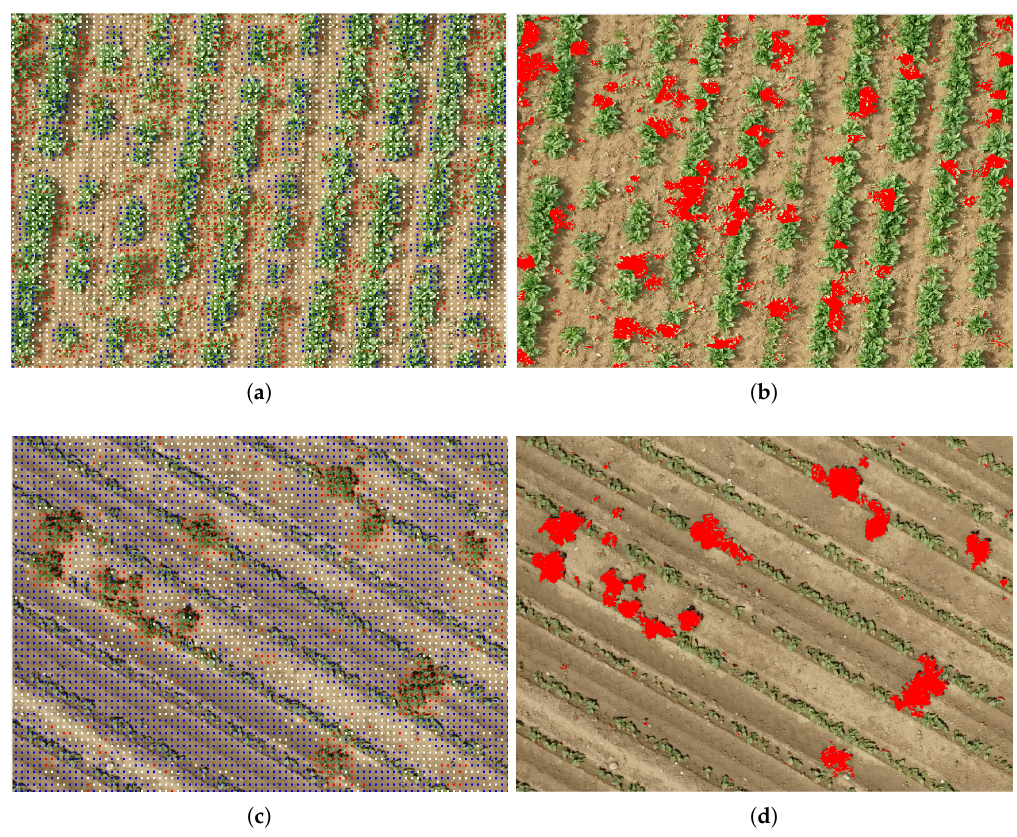
Figure 14. Examples of unmanned aerial vehicle (UAV) image classification with models created by unsupervised data in two different fields. The top two figures show samples from the spinach field and the bottom two samples are from the bean field. On the left are the samples obtained after using a sliding window, without crop line and background information. Blue, red, and white dots mean that the plants are identified as crop, weed, and an uncertain decision, respectively. On the right in red are the weeds detected after crop line and background information has been